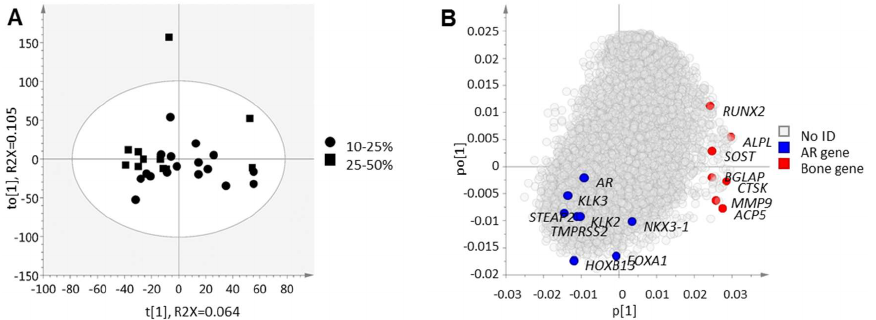
Figure 4. Orthogonal projections to latent structures analysis extracting the maximal variation in transcriptome data that co-vary with bone cell activity described by the weighted gene expression of ACP5 , ALPL , BGLAP , CTSK , MMP9 , RUNX2 and SOST t [1] score vector. ( A ) score plot of 28 bone metastases samples where each dot corresponds to one metastasis sample collected from prostate cancer patients; ( B ) loading plot of 13847 analyzed gene products. Genes with positive loading ( p ) are highly expressed in metastases with high bone cell activity and vice